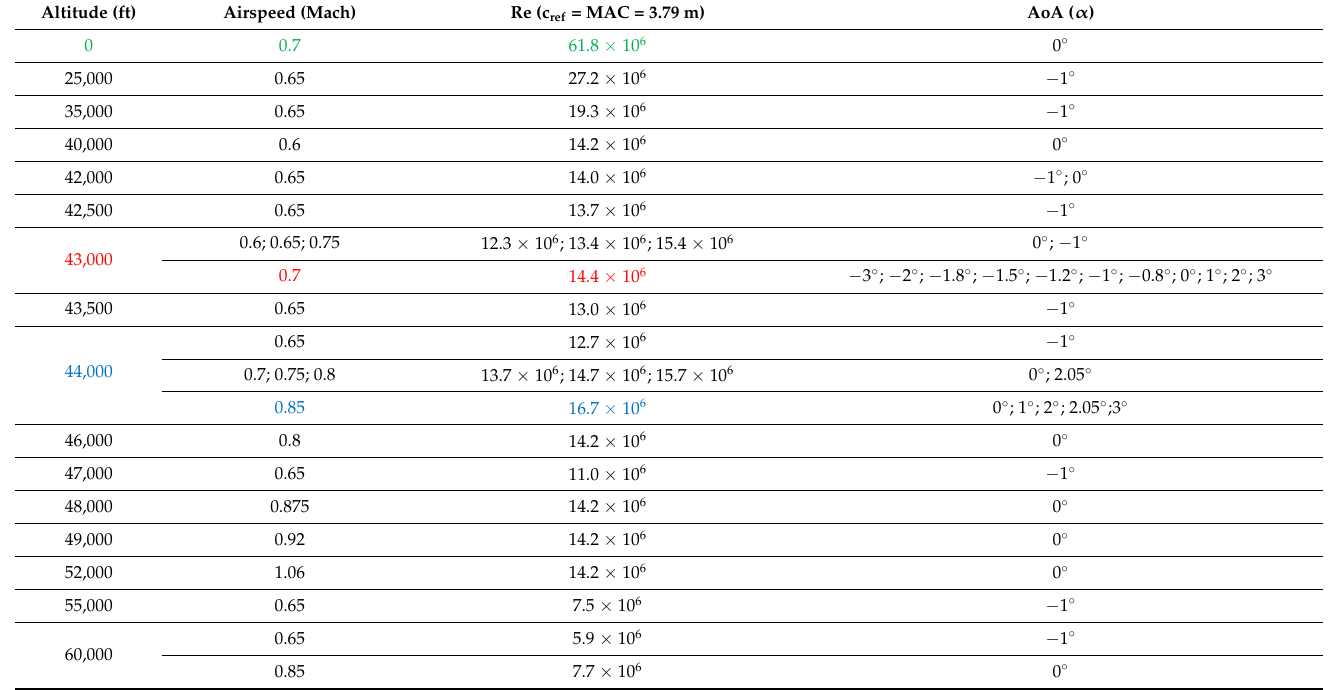
Table 5. BWA/SL aircraft: Flight conditions (S 3 , S 4 and S 1 highlighted in red, green and blue, respec- tively).